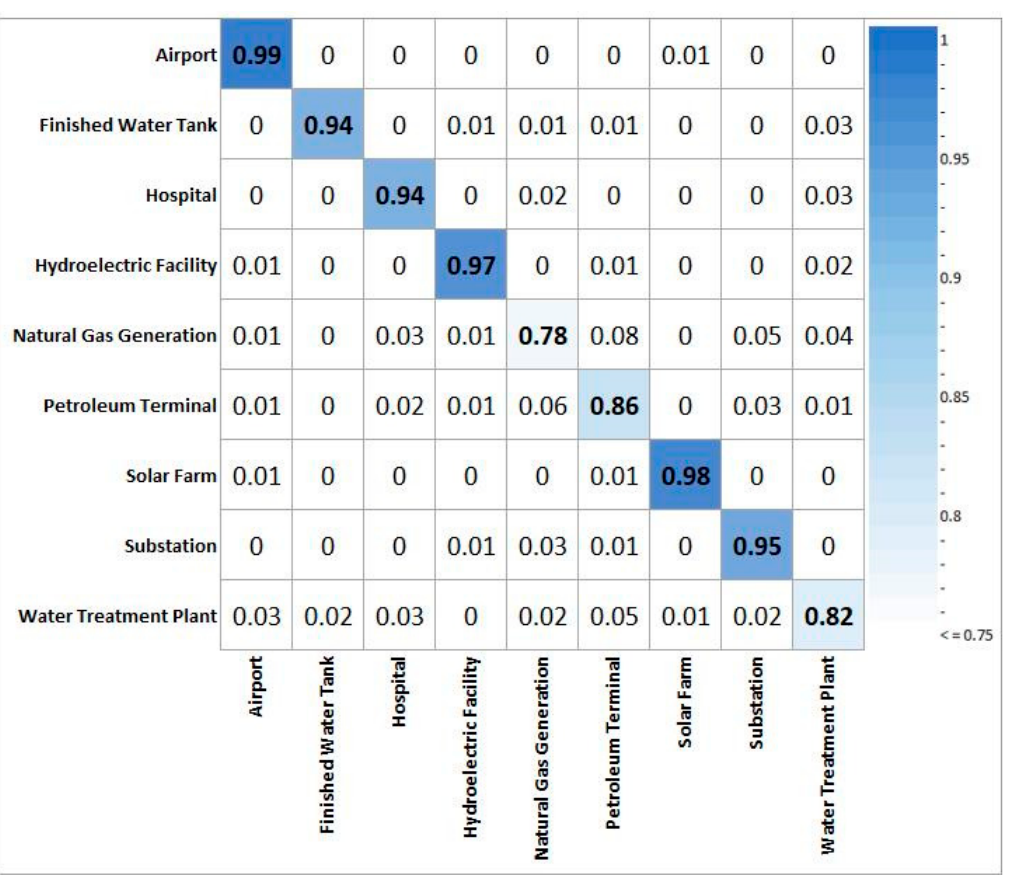
7 of 15 Figure 3. Model accuracy by epoch ( a ) and validation loss by epoch ( b ). The best accuracies for each class (i.e., each CI facility type) are ranked as follows: airports (97%), hydroelectric facilities (96%), solar farms (94%), hospitals (93%), potable water tanks (93%), substations (91%), petroleum terminals (86%), natural gas generation plants (78%), and water treatment plants (78%). These results are presented as a confusion matrix in Figure 4. The confusion matrix presents the predicted (horizontal axis)